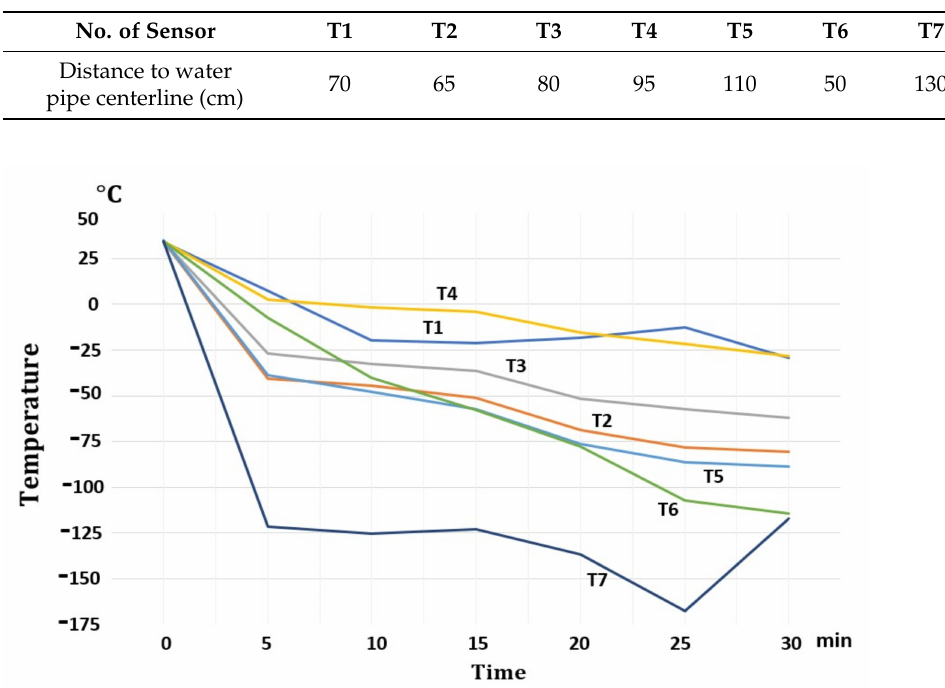
Figure 4. Temperature